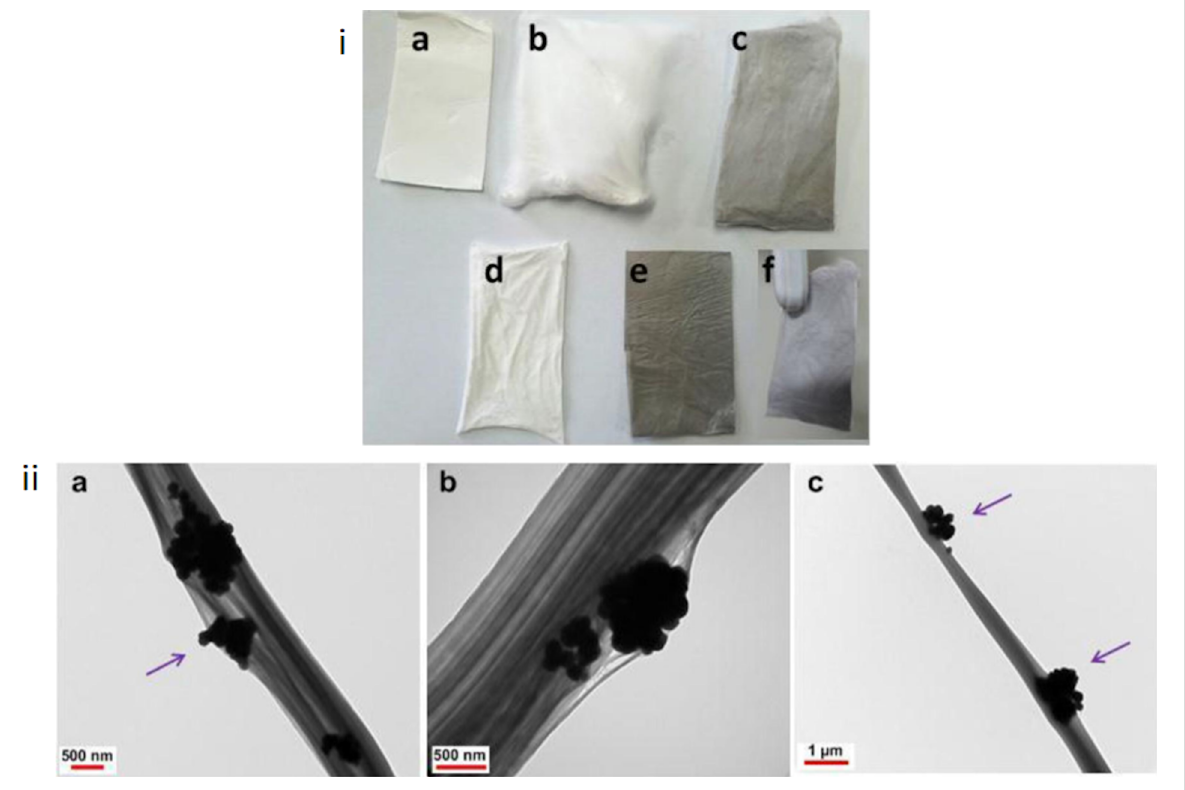
Figure 3: (i) Optical images of the fabricated mats. (a) PVDF, (b) PS, (c) Fe 3 O 4 @PS, (d) PVDF/PS, (e) PVDF/Fe 3 O 4 @PS, and (f) magnetic compos- ite mat when exposed to an external magnet. (ii) TEM images of electrospun Fe 3 O 4 @PS nanofiber at different locations of the nanofiber mat. Figure 3 was reprinted from [72] Composites Part B: Engineering, vol. 77, by Z. Jiang; L. D. Tijing; A. Amarjargal; Ch. H. Park; K.-J. An; H. K. Shon; C. S. Kim, “Removal of oil from water using magnetic bicomponent composite nanofibers fabricated by electrospinning”, pages no 311–318, Copyright (2015), with permission from Elsevier. This content is not subject to CC BY